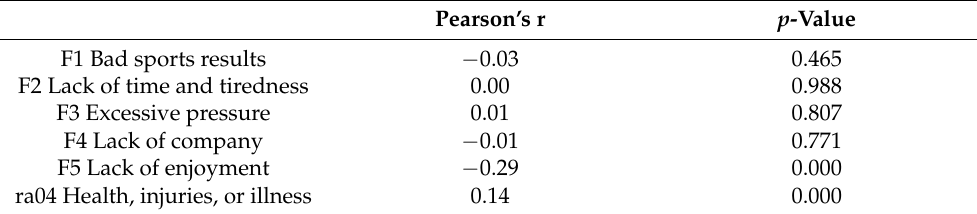
Table 7. Correlations between dropout age and reasons.